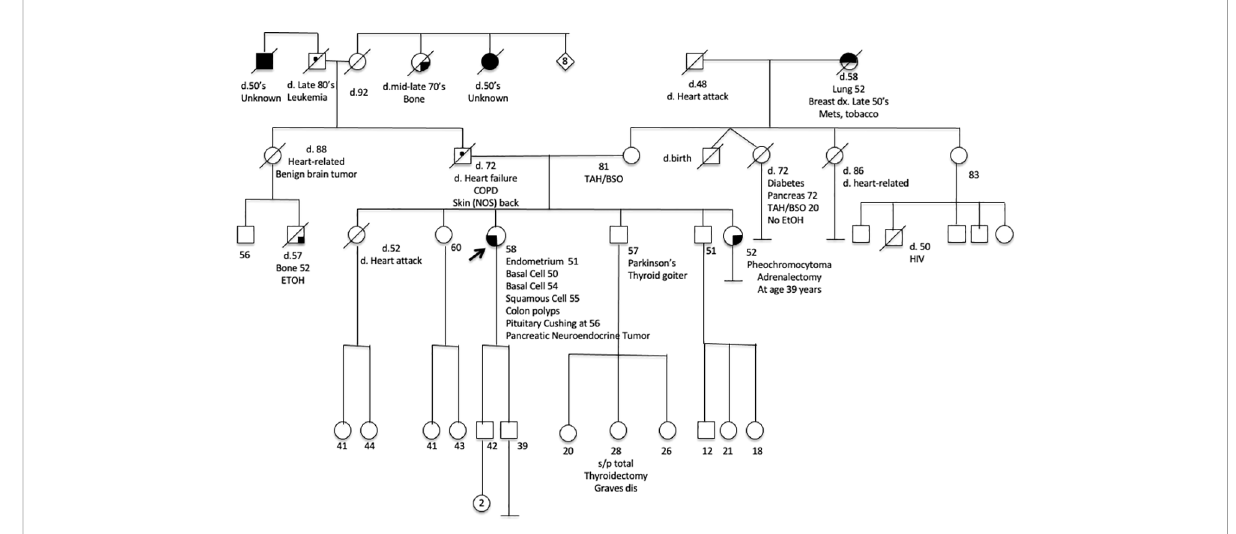
FIGURE 2 A pedigree chart of the affected